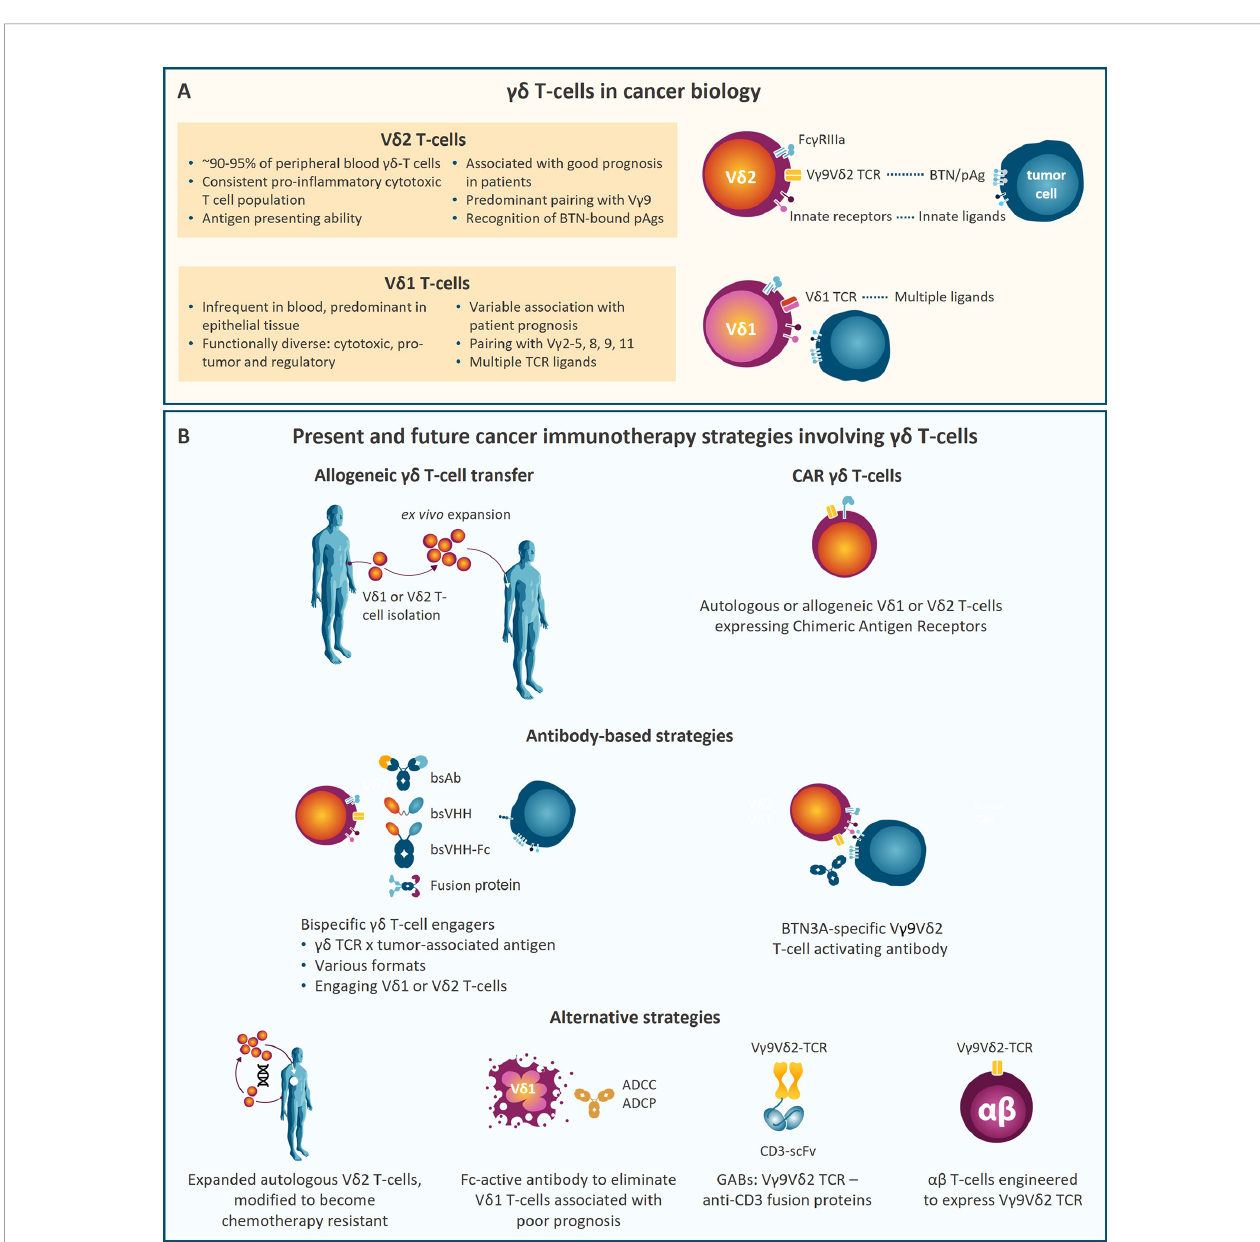
FIGURE 1 | (A) Key characteristics of the two main gd T-cell subsets, V d 2 and V d 1 T-cells, in cancer biology. (B) Schematic representation of therapeutic strategies involving gd T-cells that are currently being developed. ADCC, Antibody-dependent cellular cytotoxicity; ADCP, antibody-dependent cellular phagocytosis; bsAb, bispeci fi c antibody; bsVHH, bispeci fi c variable domain of heavy-chain only antibody; BTN, Butyrophilin; CAR, chimeric antigen receptor; pAg, phosphoantigen; scFv, single-chain variable